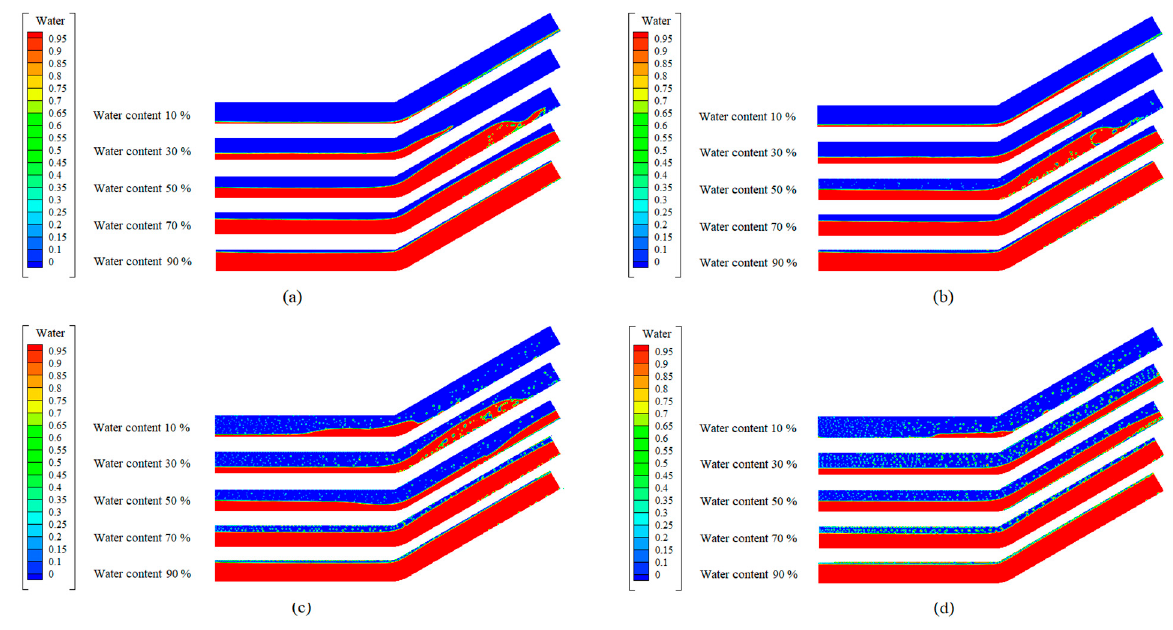
Figure 5. Distribution of the water phase in an upward-inclined pipe (30°) with different gas superficial velocities, where ( a ) 0.5 m/s, ( b ) 1 m/s, ( c ) 3 m/s, and ( d ) 5 m/s.